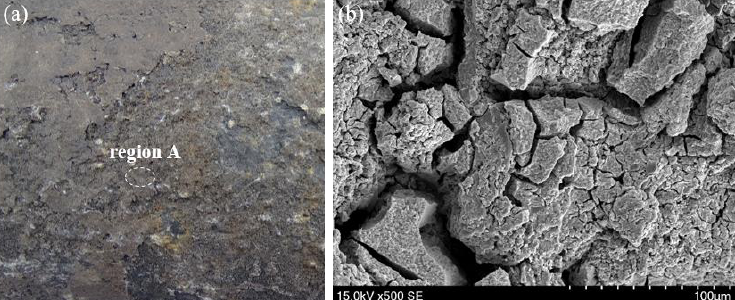
Figure 6. Sticking position of corrosion scales on the outer wall ( a ) and SEM images of corrosion stuck from the inner wall of tubing ( b ).